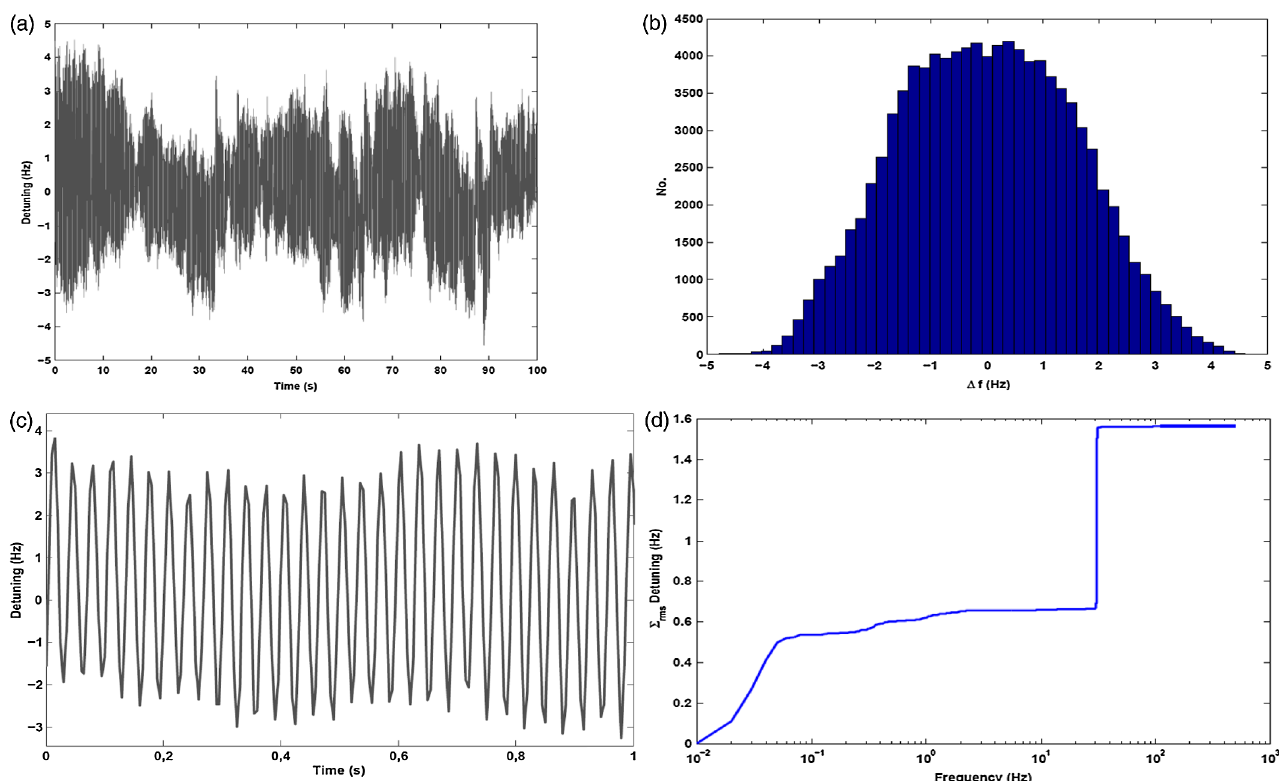
FIG. 5. (Color) (a) Typical microphonics detuning measurement. (b) The histogram of the sampled detuning events. A zoom into the time domain data (c) reveals a sinusoidal-like oscillation at around 30 Hz. The integrated amplitude spectrum, given in (d), shows that 40% of the total rms detuning is caused by low-frequency oscillations below 1 Hz modulating frequency. About 60% are caused by an excited mechanical eigenmode of the TESLA cavity